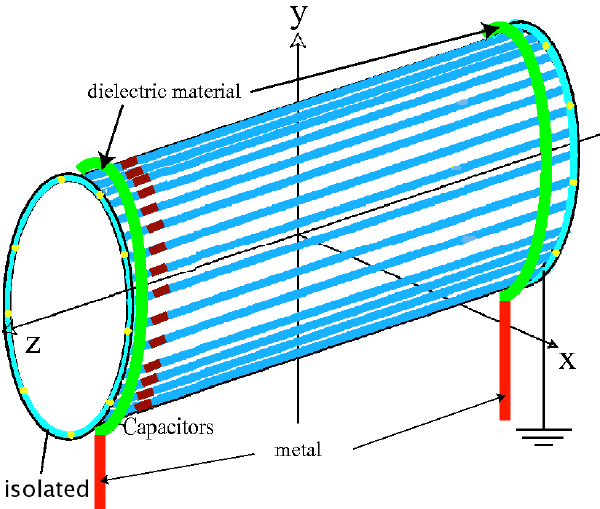
FIG. 9. (Color) The chamber with flanges is fixed by dielectric materials (green objects), which are supported by metal poles (red objects) with the 3 GeV RCS at J-PARC. Cu stripes terminate at either end as capacitors. One side of the chamber